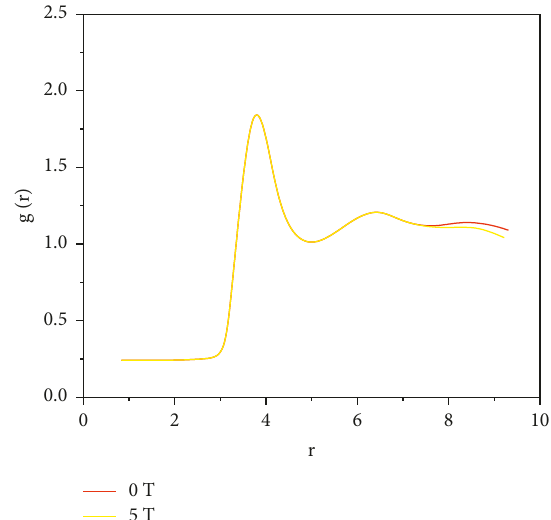
Figure 4: Effect of magnetic field on microstructure of pure water g